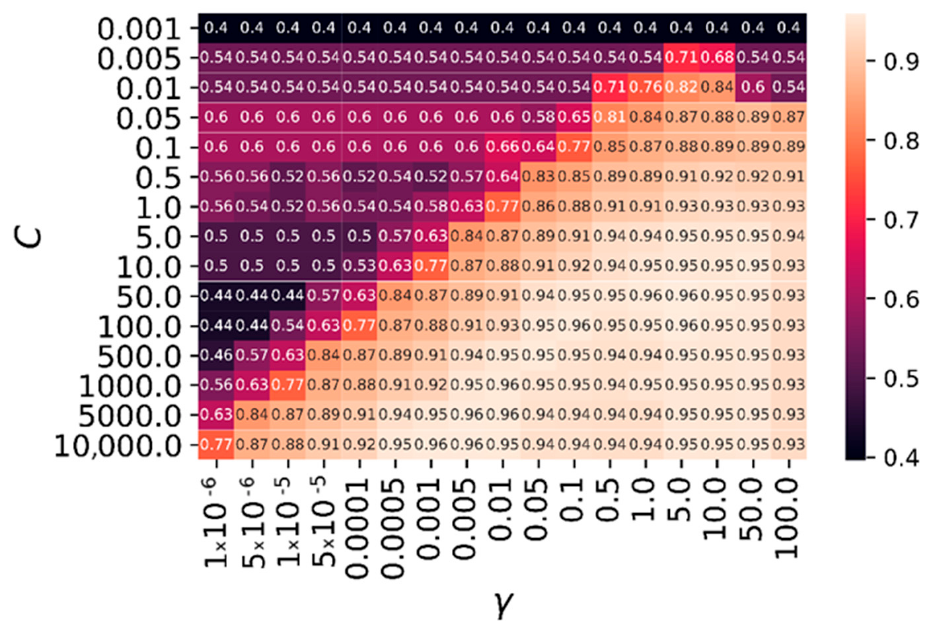
Figure 4. Average validation accuracy of the SVM method for a 10-fold cross-validation procedure, over different combinations of parameters γ (inverse kernel radius parameter) and C (regularization parameter). A large region of the parameter space allowed us to obtain good quality results with an accuracy around 0.96, meaning that the method was robust in the parameter setting.